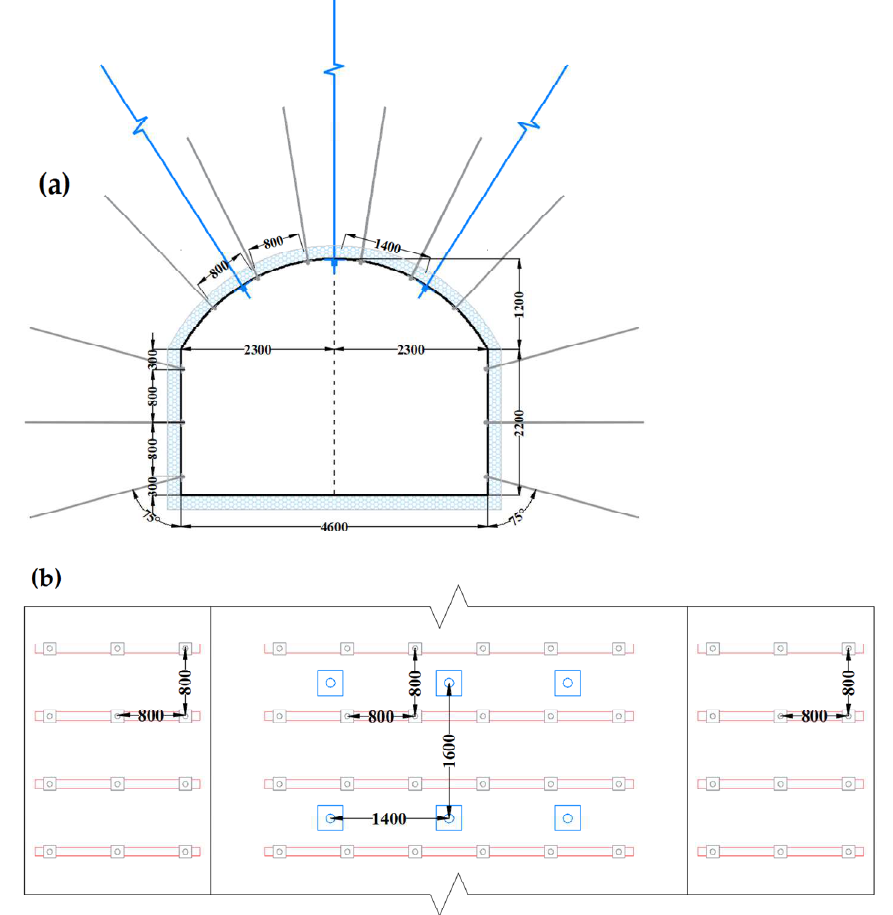
Figure 16. 1302 transport roadway support technical scheme: ( a ) roadway support section diagram; ( b ) roadway support floor plan.